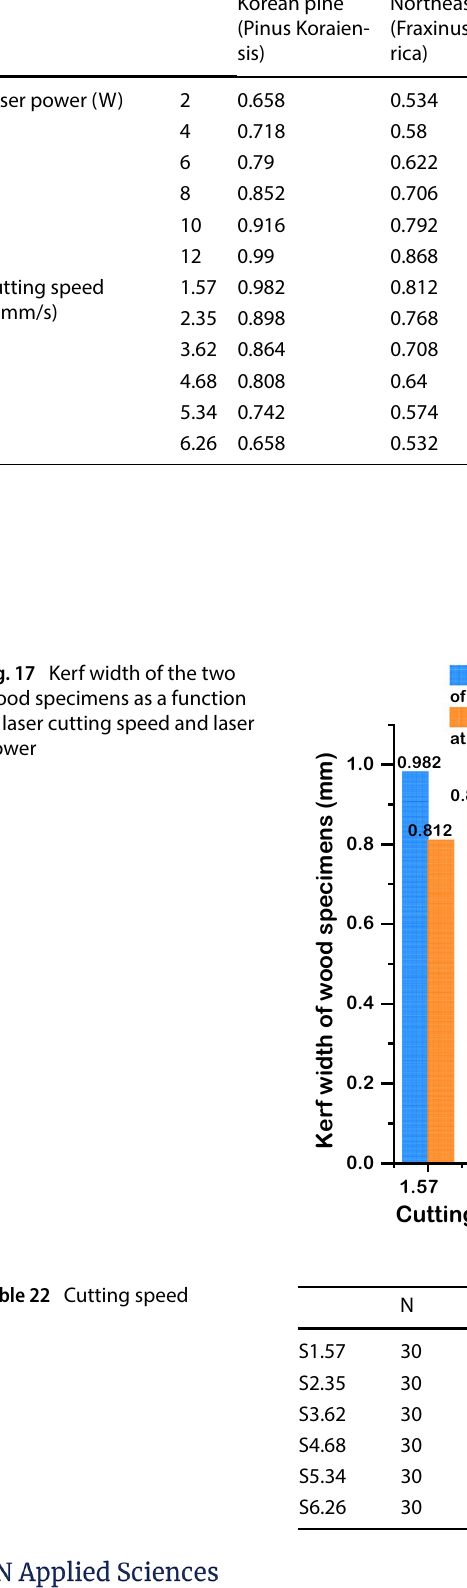
Table 21 Kerf width data of the two wood specimens under M M 2 Machining parameters